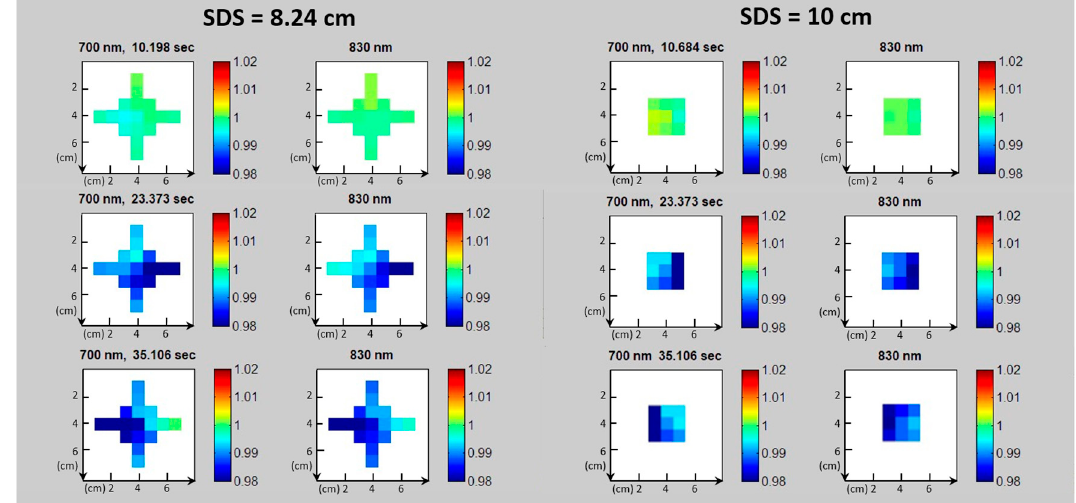
Figure 11. Back-projection images reporting the normalized photocurrents after 700 nm and 830 nm irradiation, related to three different instants for 8.24 cm and 10 cm SDSs.